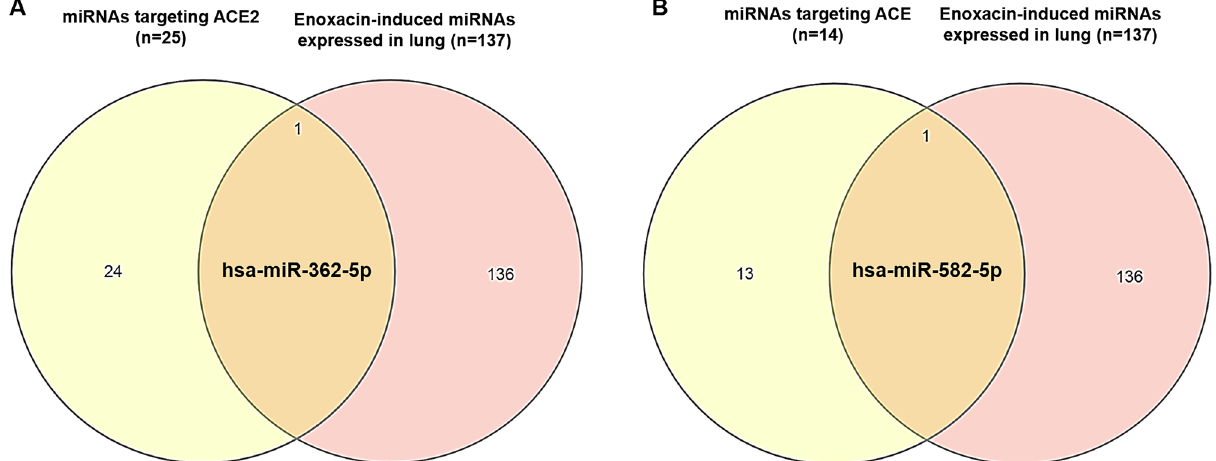
Figure 1. Venn diagram analysis of enoxacin-induced miRNAs and miRNAs targeting cell entry receptors necessary for SARS-CoV-2 infection. Entry receptors including ACE2 and ACE could be targeted by two enoxacin-induced miRNAs.